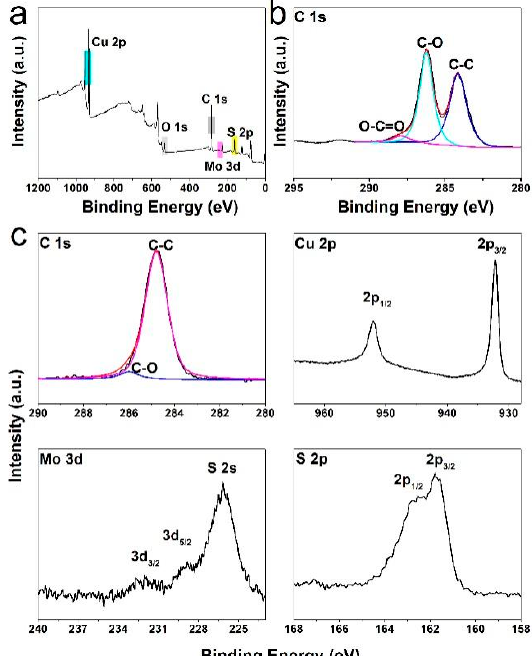
Figure 3. ( a ) Wide scan XPS spectrum and ( b ) high-resolution XPS spectrum in C 1s region of as-synthesized Cu 2 S-MoS 2 /rGO composite. ( c ) High-resolution XPS spectra for individual elements in Cu 2 S-MoS 2 /rGO composite, including C 1s, Cu 2p, Mo 3d, and S 2p.